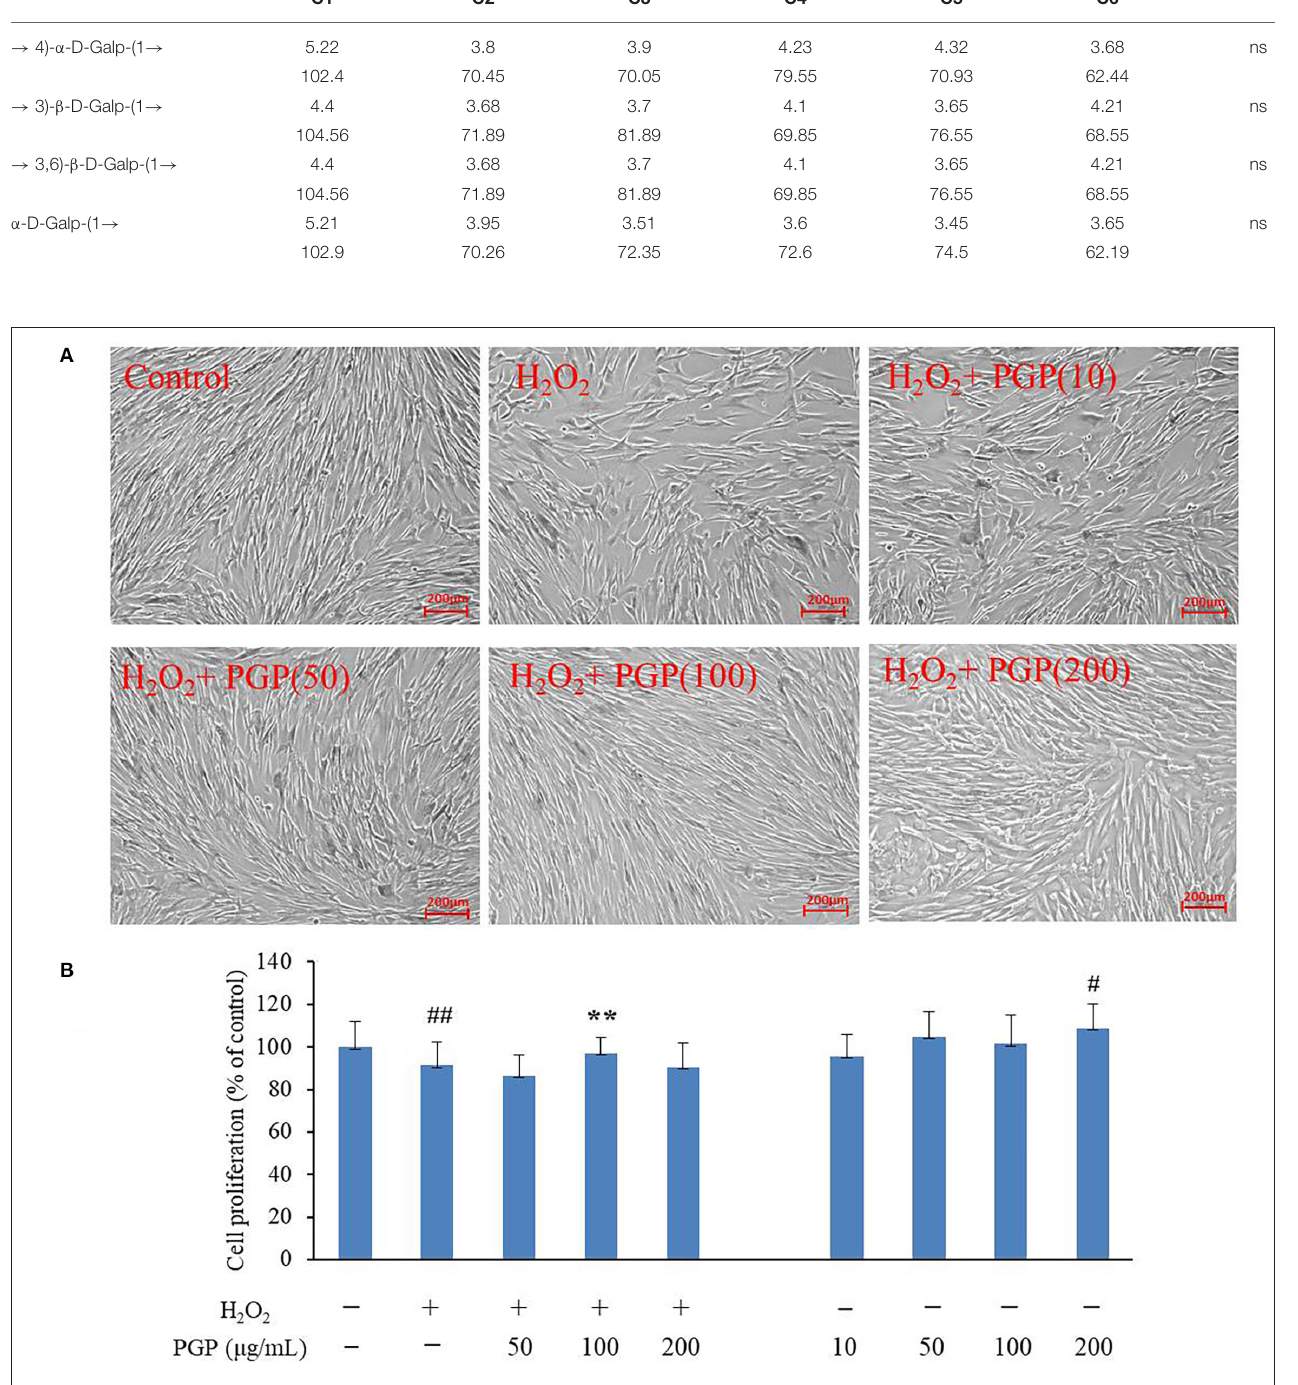
Frontiers in Nutrition |